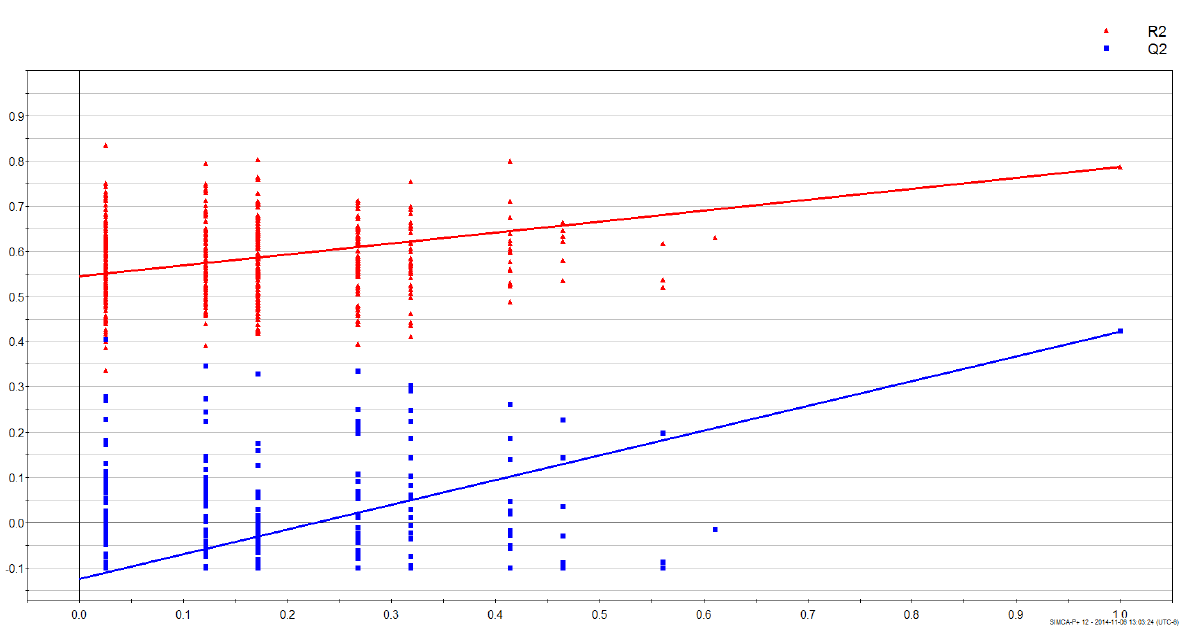
Figure 1. PLS-DA score plot obtained for male and female Humboldt Penguins.